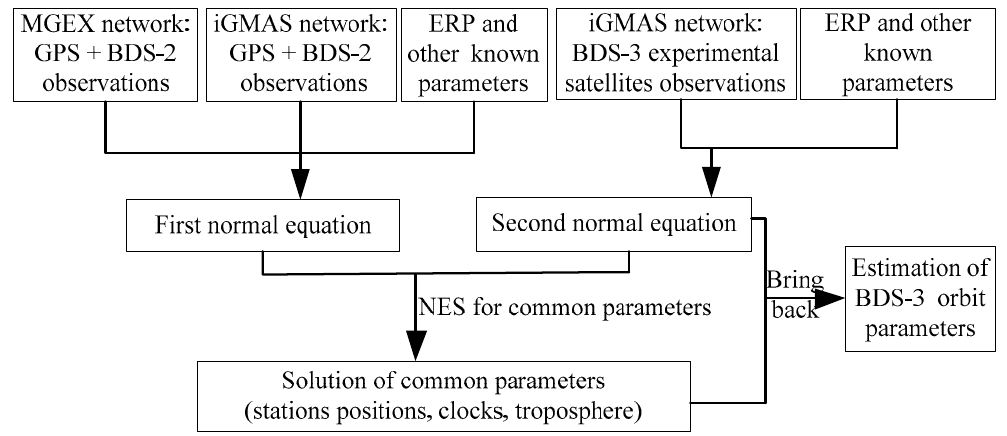
Figure 5. Flowchart of BDS-3 orbit determination based on NES.